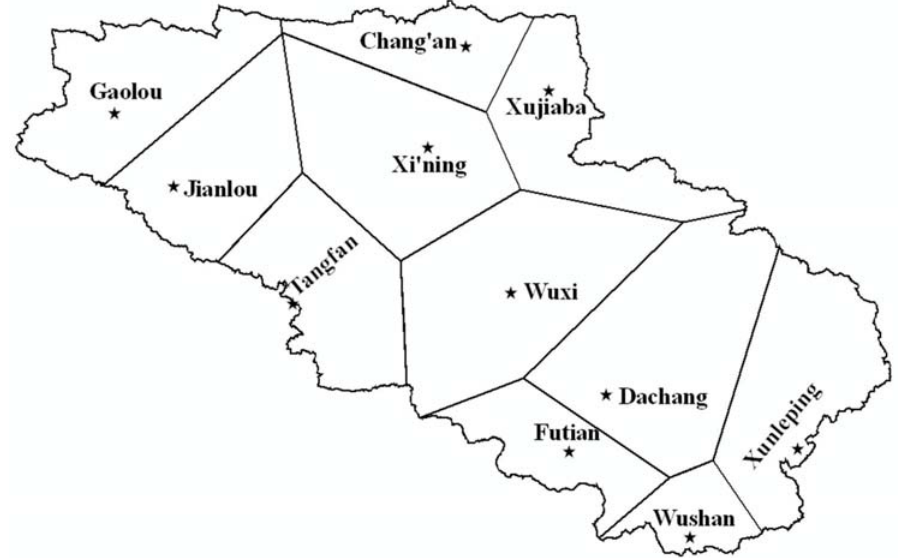
Figure 7. Spatial distribution of raingauges and associated Thiessen polygons in the Daning River